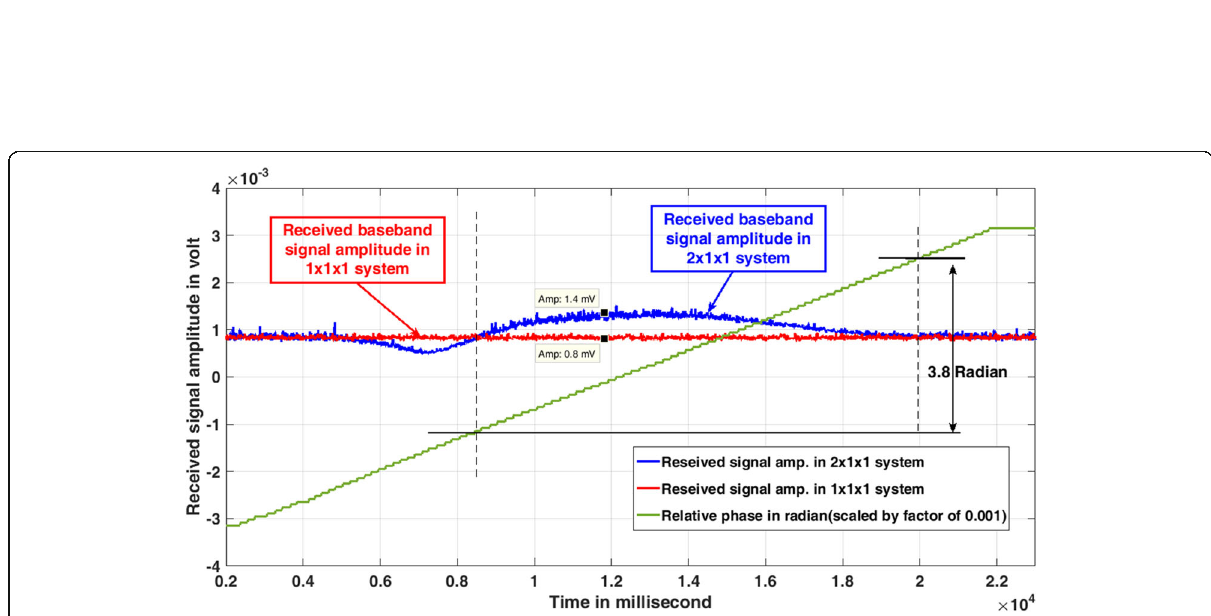
Fig. 10 Measured data signal amplitude after demodulation using one-transmitter query 1 × 1 × 1 (red curve) and two transmitter query 2 × 1 × 1 (blue curve) with relative phase